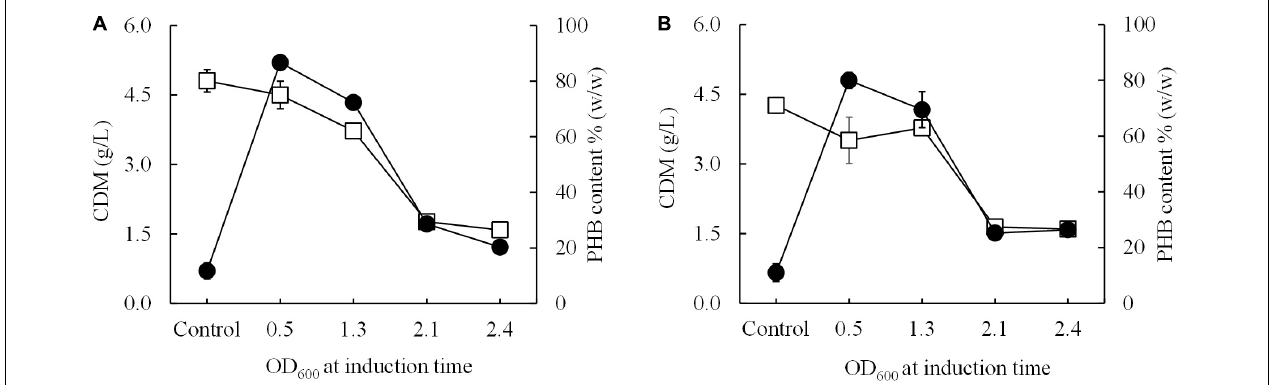
FIGURE 4 | Effect of the growth phase suitable for cold-shock induction on CDM and PHB content (% w/w) under the short-induction method. The different growth phases were investigated by varying OD 600 based on cultivation time [0.5 (2 h, early exponential phase), 1.3 (4 h, middle exponential phase), 2.1 (6 h, late exponential phase), and 2.4 (10 h, stationary phase)] for (A) E. coli JM109 (pColdI- phaCAB A - 04 ) and (B) E. coli JM109 (pColdTF- phaCAB A - 04 ). A control experiment was performed with 0.0 mM IPTG induction. All the data are representative of the results of three independent experiments and are expressed as the mean values ± standard deviations (SDs). Symbols: open squares, CDM (g/L); closed circle, PHB (g/L).